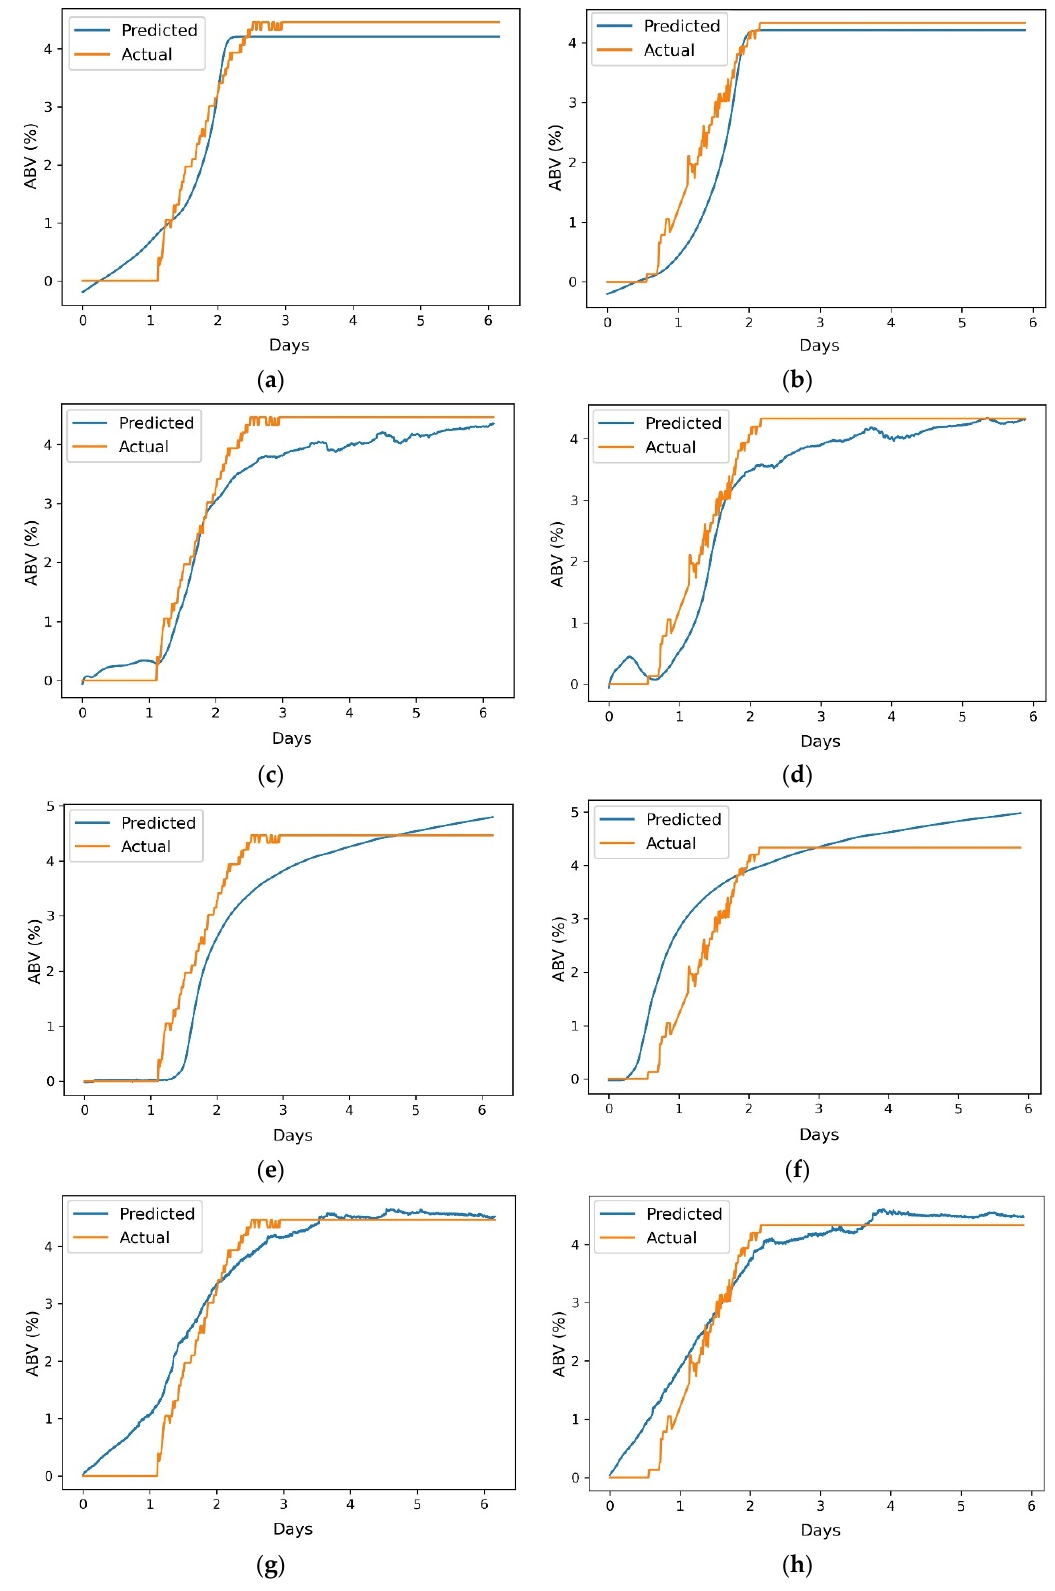
Figure 5. Predicted alcohol by volume percentage from the final LSTM models for the two test set batches (batches 12 and 13): ( a ) Model 1, Batch 12; ( b ) Model 1, Batch 13; ( c ) Model 2, Batch 12; ( d ) Model 2, Batch 13; ( e ) Model 3, Batch 12; ( f ) Model 3, Batch 13; ( g ) Model 4, Batch 12; ( h ) Model 4, Batch 13.